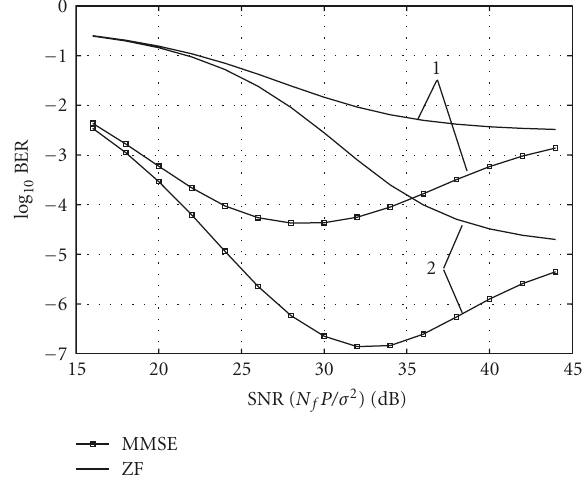
Figure 3: BER performance of MC-CDMA with MMSE and ZF equalizers, evaluated from (21), for RFO = 0.05 (plots marked 1) and RFO = 0.03 (plots marked 2) ( N f = 64 and the channel realization is CR-1 given in Table 1, and symbols are from 4-QAM constellation with P = 1).